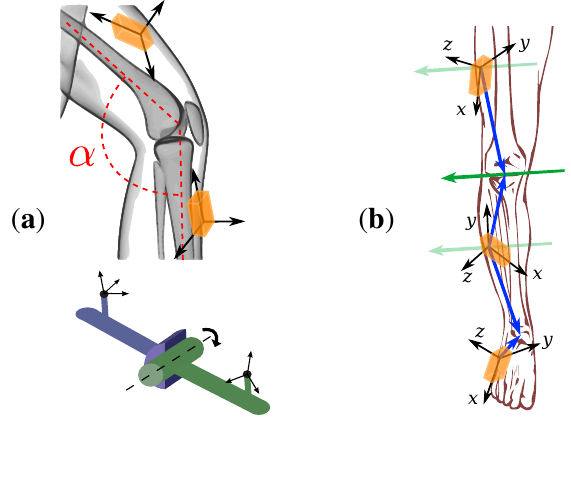
Figure 1. The placement of inertial sensors on the human body, the definition of joint angle and a model of a hinge joint. ( a ) The local sensor coordinate axes are not aligned with the physiological axes and planes by which the joint angle, α , is defined; ( b ) the coordinates of the joint axis direction (green arrows) and the joint position (blue arrows) in the local coordinate systems of the sensors characterize the sensor-to-segment